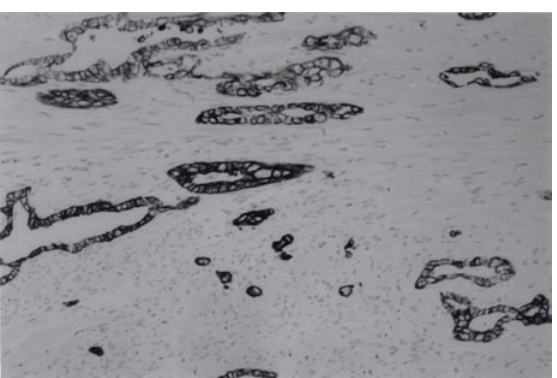
Figure 4. Immunohistochemical staining for epithelial cells showing invasive adenocarcinoma infiltrating the muscle wall of the duplication cyst (Ber EP4, magnification x